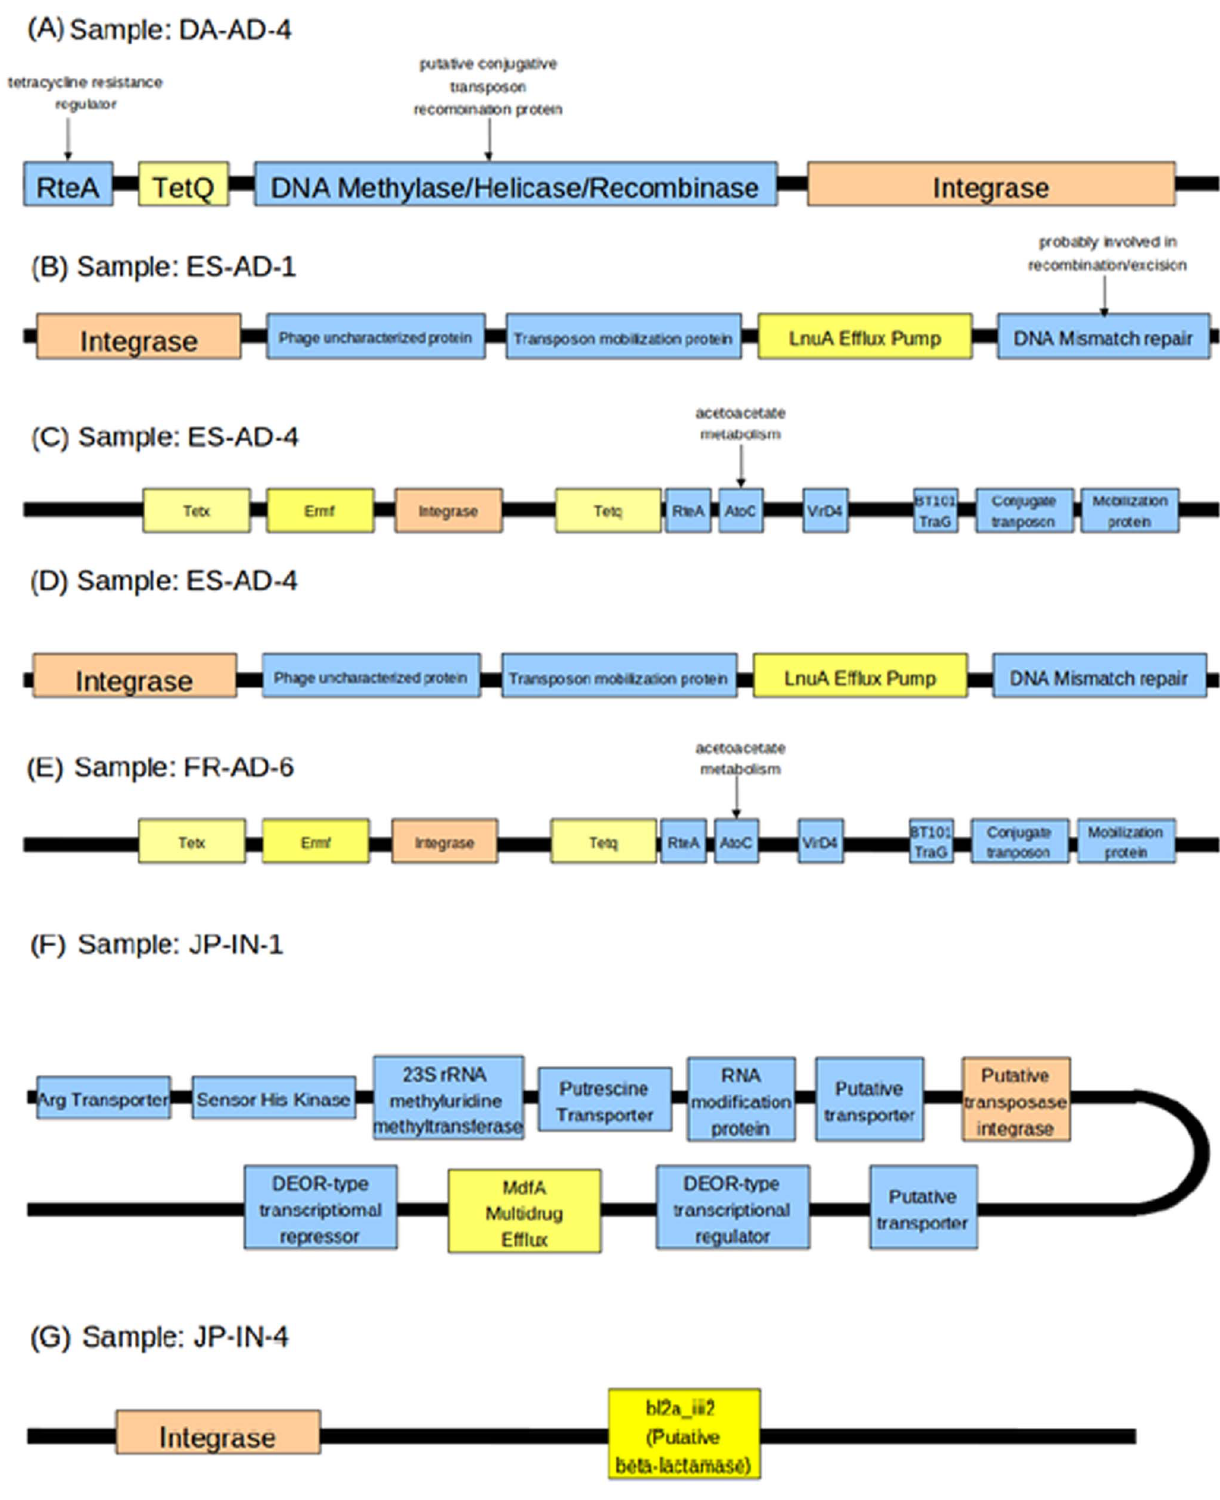
Figure 10. Details of the genomic contigs containing probable antibiotic resistance genes (highlighted in yellow) in the vicinity of integrase genes (highlighted in orange).